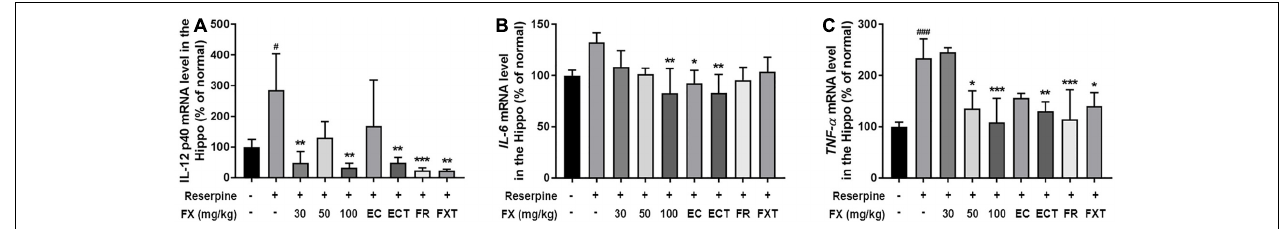
FIGURE 5 | Effect of FX extract and its components on the expression of IL-12 p40, IL-6, and TNF- α mRNA levels. (A) IL-12 p40 , (B) IL-6, and (C) TNF- α mRNA levels were measured in the hippocampus of the mice with real-time PCR ( n = 3–4). FX extract, EC, ECT, and FR increased pro-inflammatory cytokines mRNA levels.